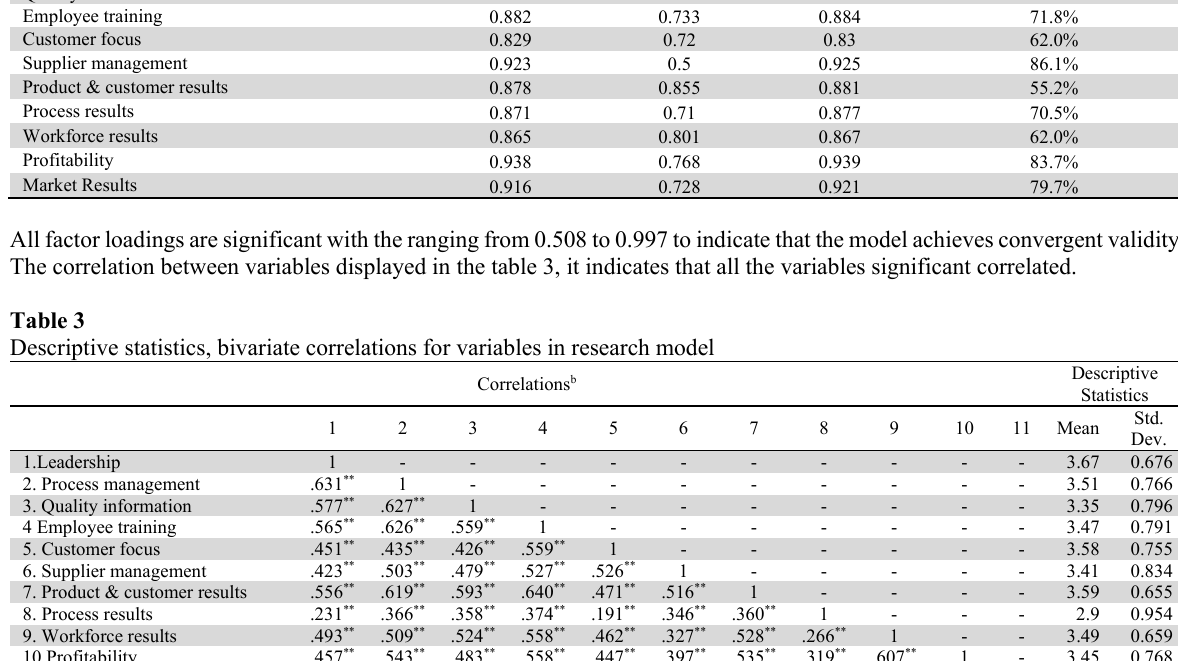
Average variance extracted (AVE) %